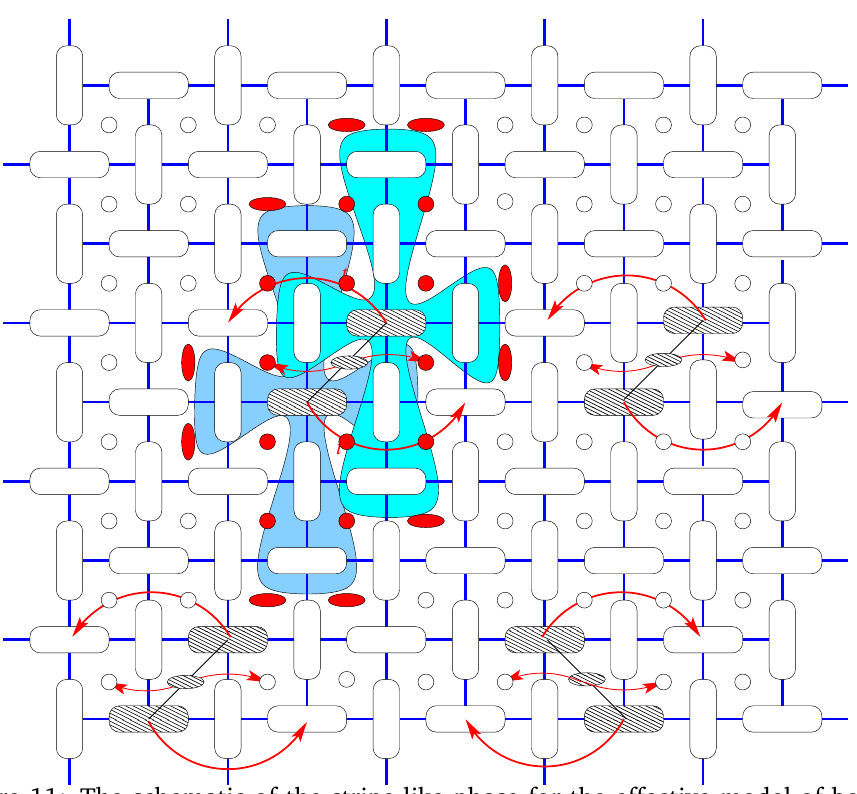
Figure 11: The schematic of the stripe-like phase for the effective model of bound triplons. Here, the same notations for dimers as in Fig. 3 are used. Small circles and ellipses denote sites of the dual lattice. The empty circles correspond to the empty sites, horizontally (vertically) oriented ellipses mark the bound state of two triplons in the horizontal (vertical) direction. The hard-core condition for bosons on the dual lattice is outlined by red circles (sites are forbidden for any boson) and red horizontal or vertical ellipse (site is forbidden for h - or v -boson). Red arrows indicate the possible hopping of triplons within a bound-triplon state, and the corresponding hopping of a triplon pair on a dual